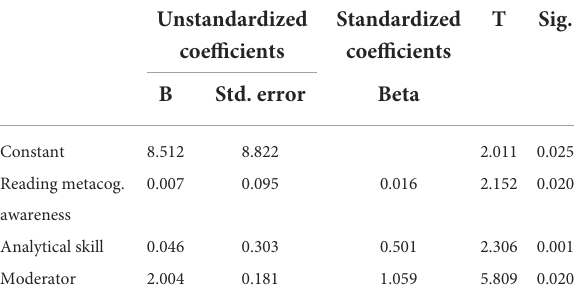
analyzing skill.